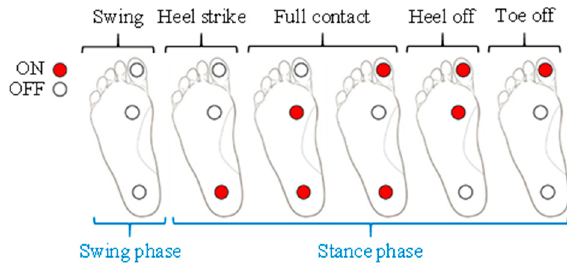
Figure 3. Four sub-phase labeling criteria according to the 3-ch FSR measurement result.